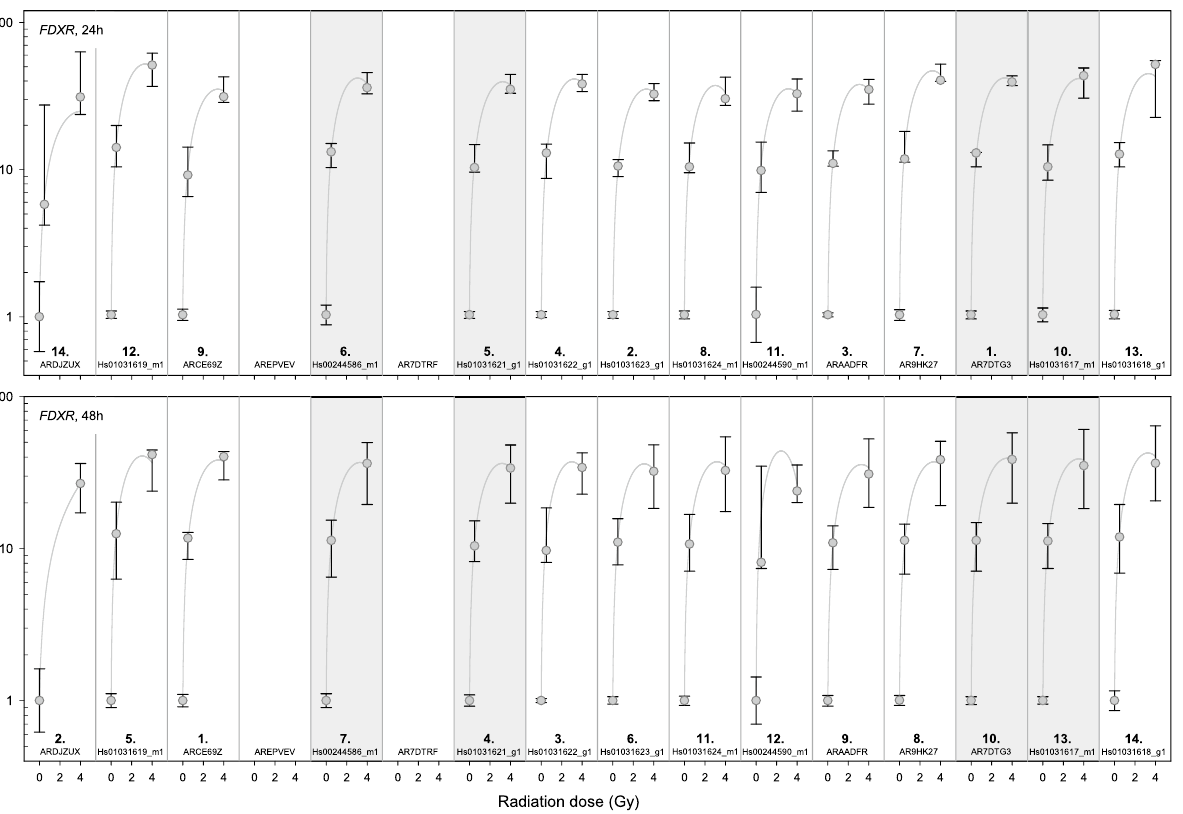
Figure 3. Inter-individual variability of FDXR TaqMan assays. Plotted is the differential gene expression relative to unexposed of FDXR for each assay after 24 h (upper panel) and 48 h (lower panel). The symbol represents the median, and the lower and upper whiskers represent the minimum and maximum fold change, respectively. Additionally plotted is the 2nd order regression line for each TaqMan assay. After summing up the standard deviations of radiation dose, ranks were assigned. 1st rank is the lowest inter-individual variability, 14th rank is the highest. The four assays highlighted in gray are those most suitable for biodosimetry as identified in Fig. 2 using other criteria (baseline, dose dependency, time persistency). Assay labels starting with the two capital letters “AR” can be found after creating an account at Thermo Fisher web site, entering the “Reorder Custom Assays” section with the implemented search function in the “Custom TaqMan Assay Design Tool”.